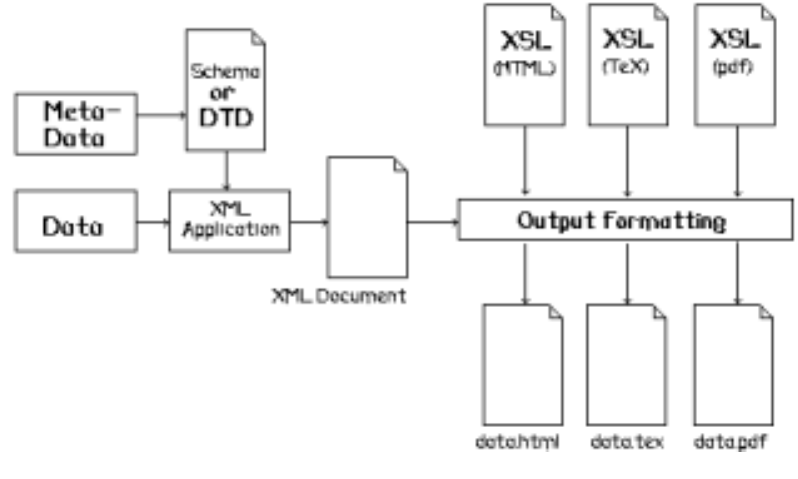
Figure 8: Preparation of XML data and examples of output format-